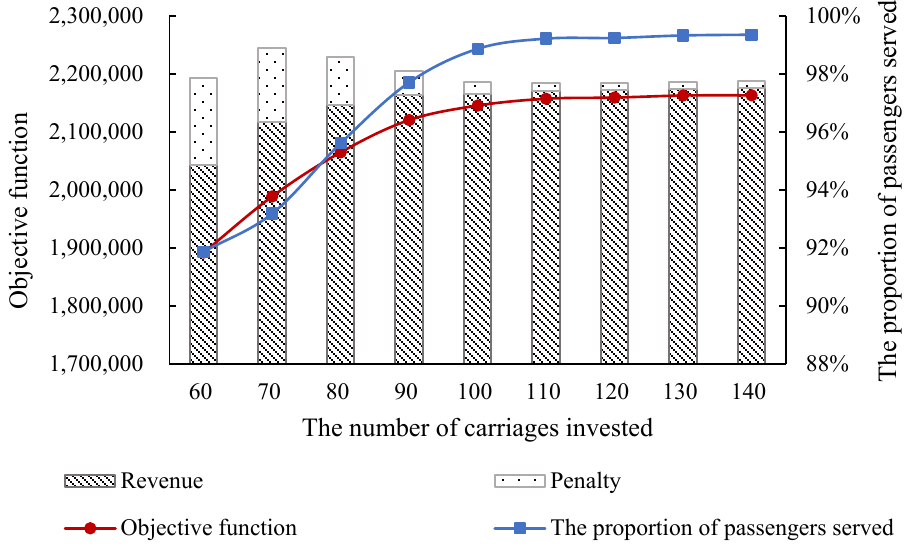
Figure 5. The trend of the objective function and the proportion of passengers that are served.